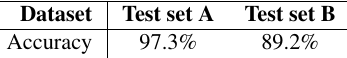
Table 5. Quality comparison of the classifier for the weed class in test set of B, before and after retraining.